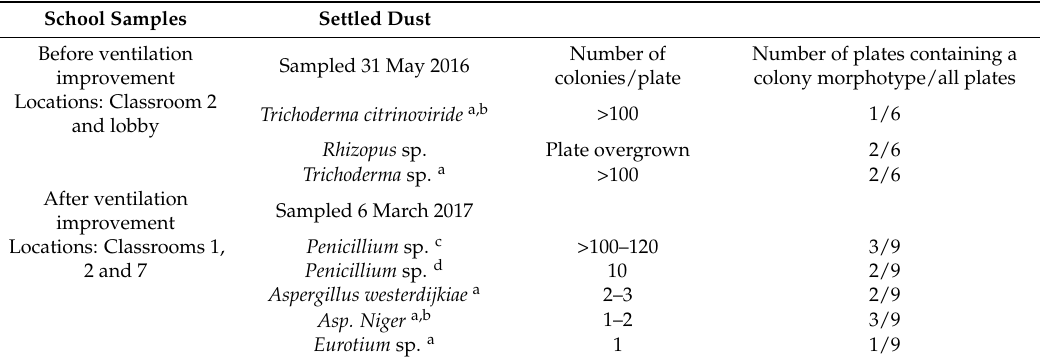
Table 4. Cultivable mycobiota in settled indoor dust sampled from surfaces above floor level in four different locations of the school. Dust was sampled before and after the ventilation improvement and cultivated on three plates per